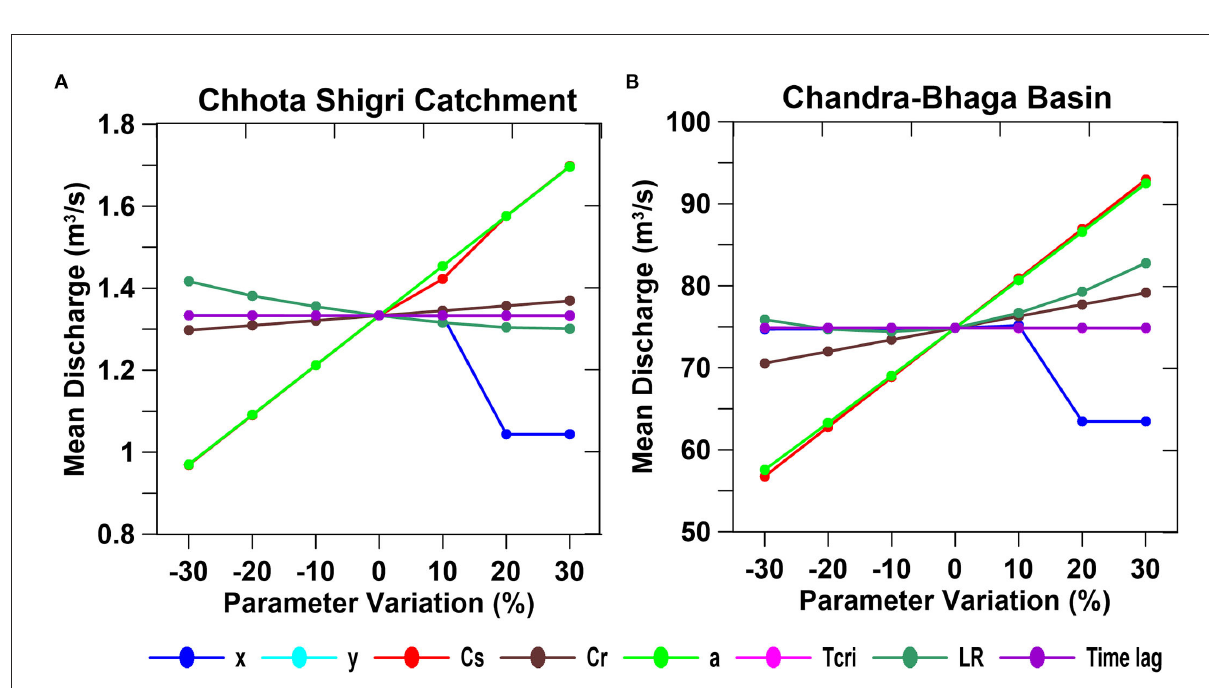
FIGURE12 Sensitivity analysis results for Chhota Shigri Catchment (A) and Chandra-Bhaga Basin (B) . The X-axis shows the percentage variation in the values of each parameter and the Y-axis shows the corresponding simulated mean daily discharge